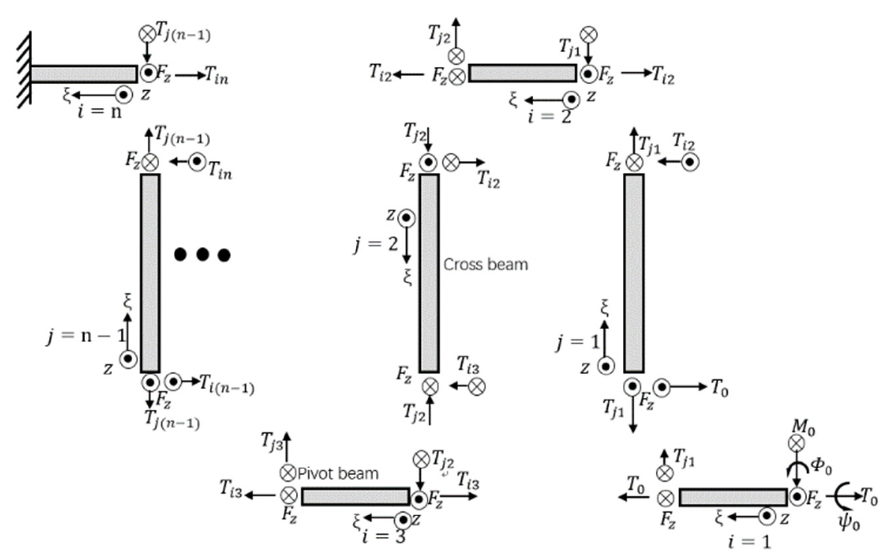
Figure 2. The free body diagram of the spring structure.